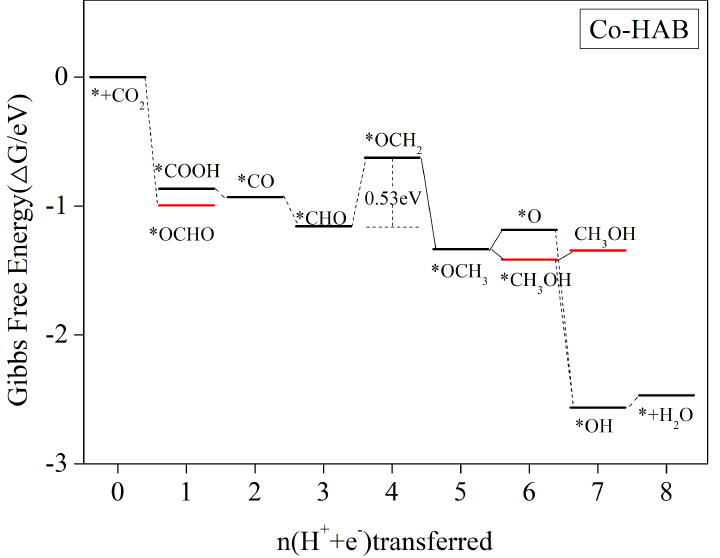
Figure 6. Gibbs free energy profiles for the CO 2 RR along the most favorable pathways for Co–HAB at zero potential. The free energy zero is set to a CO 2 molecule in the gas phase with a clean catalyst surface. After CO 2 adsorption by Co-HAB, the steps of paper protonation to form *COOH or *OCHO are all free energy reduction processes, which are exothermic and occur